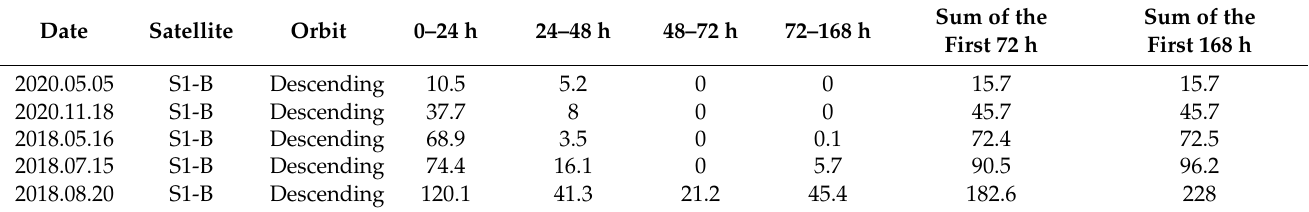
Table 5. Information of 5 rainfall events (Unit: mm).